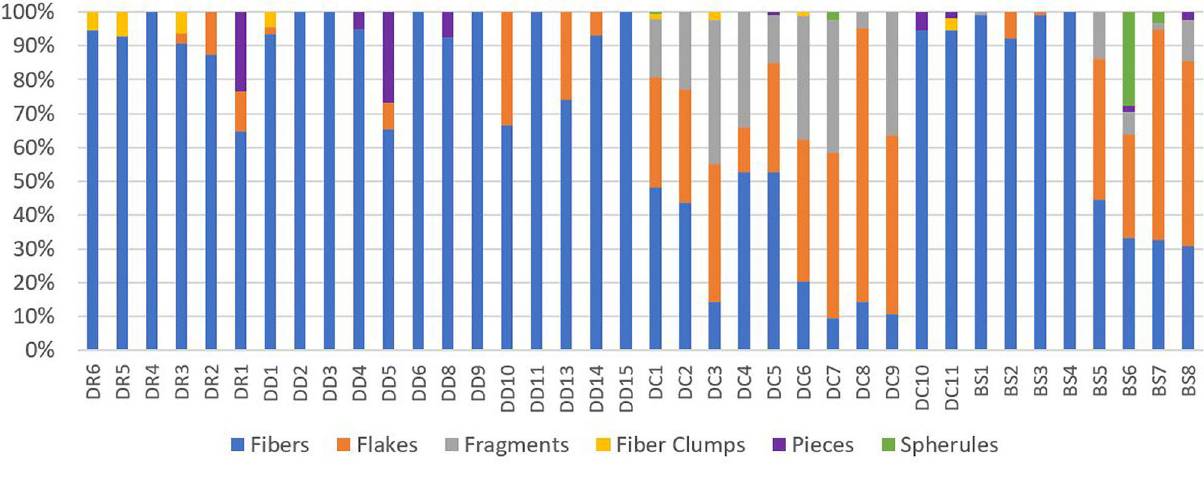
Figure 5. Observed microplastics